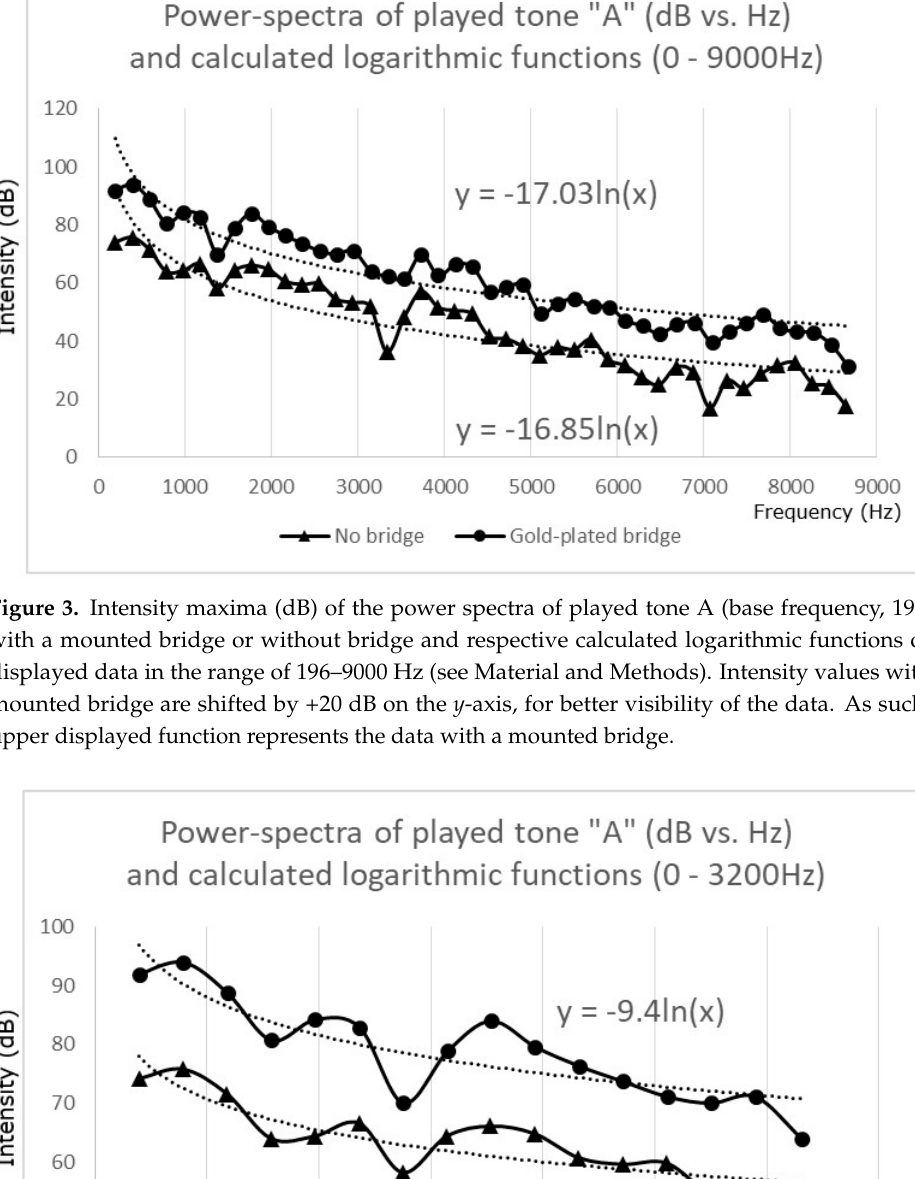
Figure 4. Same data as in Figure 1 with respective calculated logarithmic functions in the range of 196-3200 Hz (see Material and Methods). Intensity values with mounted bridge are shifted by +20 dB on the y -axis, for better visibility of the data. As such, the upper displayed function represents the data with a mounted